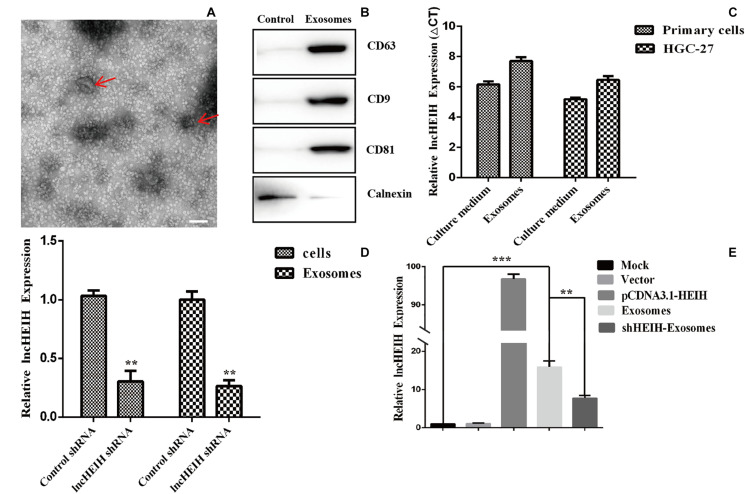
LncHEIH encapsulated in exosomes can be released extracellularly by gastric cancer cells and enter normal cells. (A) Electron scanning microscopy of exosomes released by gastric cancer cells (scale bar = 200 nm). (B) Immunoblot showing the protein levels of CD63, CD9, CD81, and Calnexin in the isolated exosomes. (C) LncHEIH mRNA levels in exosomes (from 20 ml serum-free medium) and 20 ml serum-free medium. (D) LncHEIH levels in cells and exosomes when gastric cancer cells were transfected with shHEIH-2 and cultured in serum-free medium. (E) LncHEIH mRNA levels in GES-1 cells when exosomes and shHEIH-exosomes were added to the cultures for 48 h. Data are shown as the means ± SD. The images are representative of three independent experiments. *P < 0.05, **P < 0.01, ***P < 0.001.